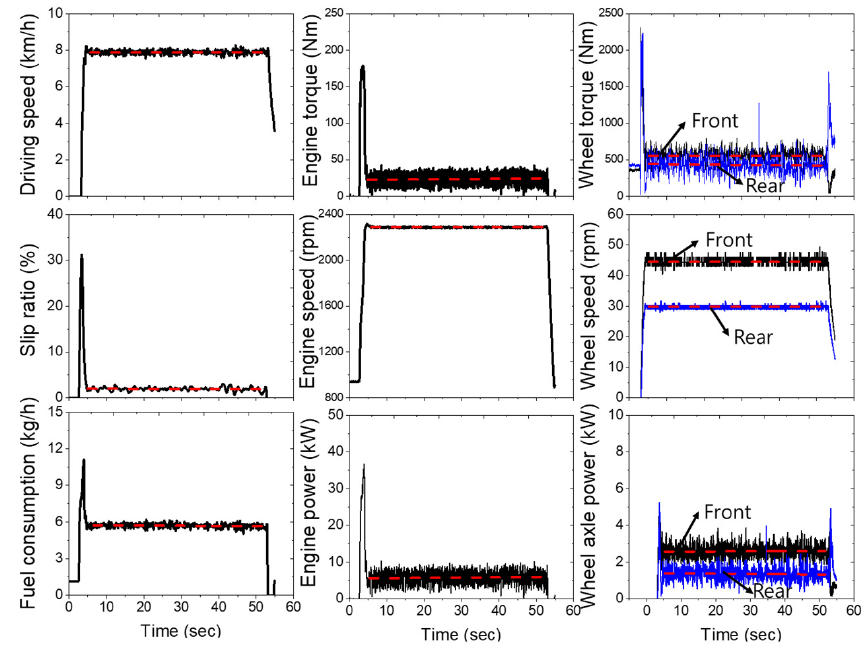
Figure 4. Driving load of 42 kW agricultural tractor at M3 gear selection.